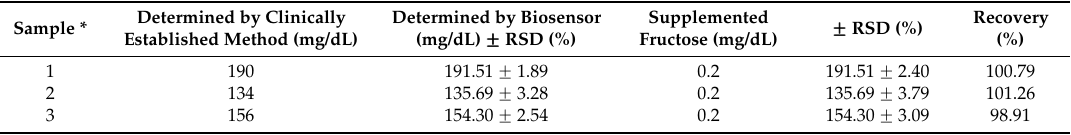
Table 2. Determination of glucose level in serum samples ( n = 3) for specificity